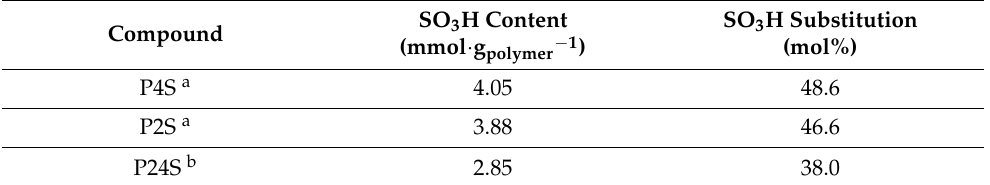
Table 1. Oligomers SO 3 H content determined by titration.